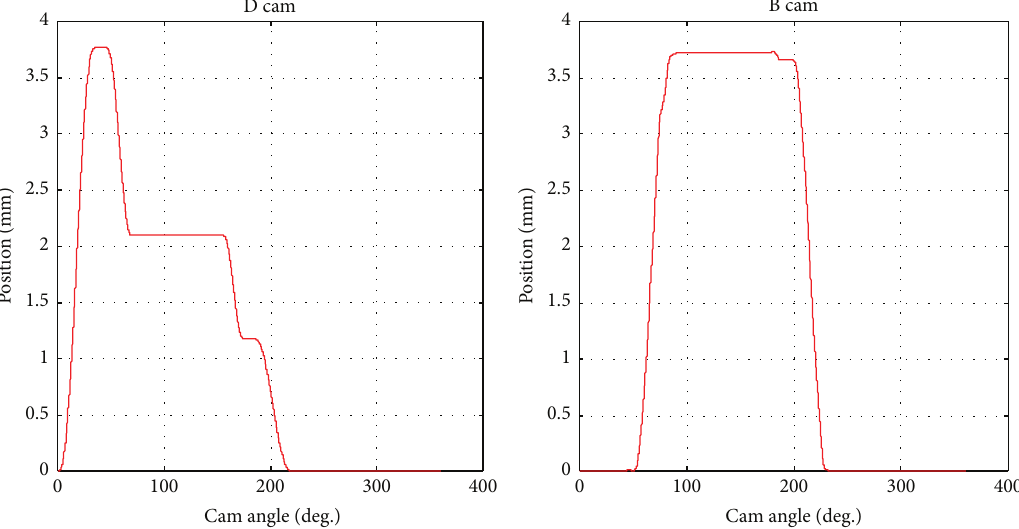
Figure 2: Displacement profiles of fixtures D and B.